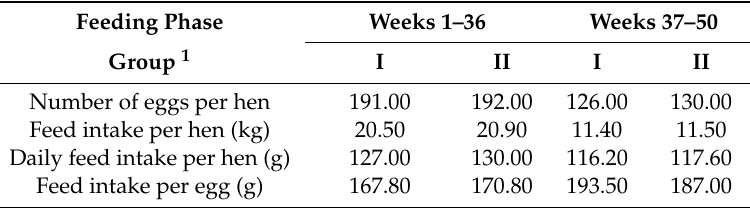
Table 5. Mean values of the productivity parameters of laying hens during the experiment *.